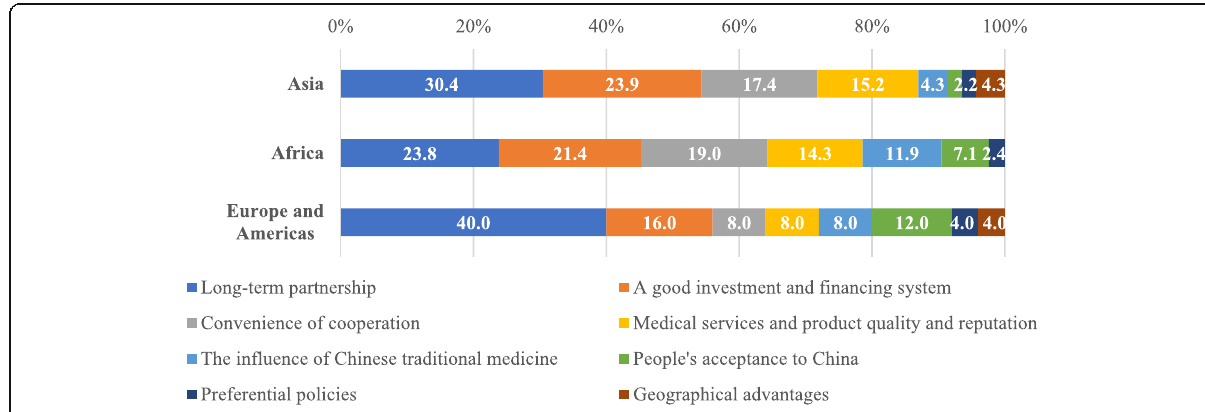
Fig. 2 Advantages perceived by respondents from the countries of Asia (n = 24), Africa (n = 19), Europe and Americs (n = 15) on their countries ’ participation in BRHC with China or the reasons for choosing China as the partner